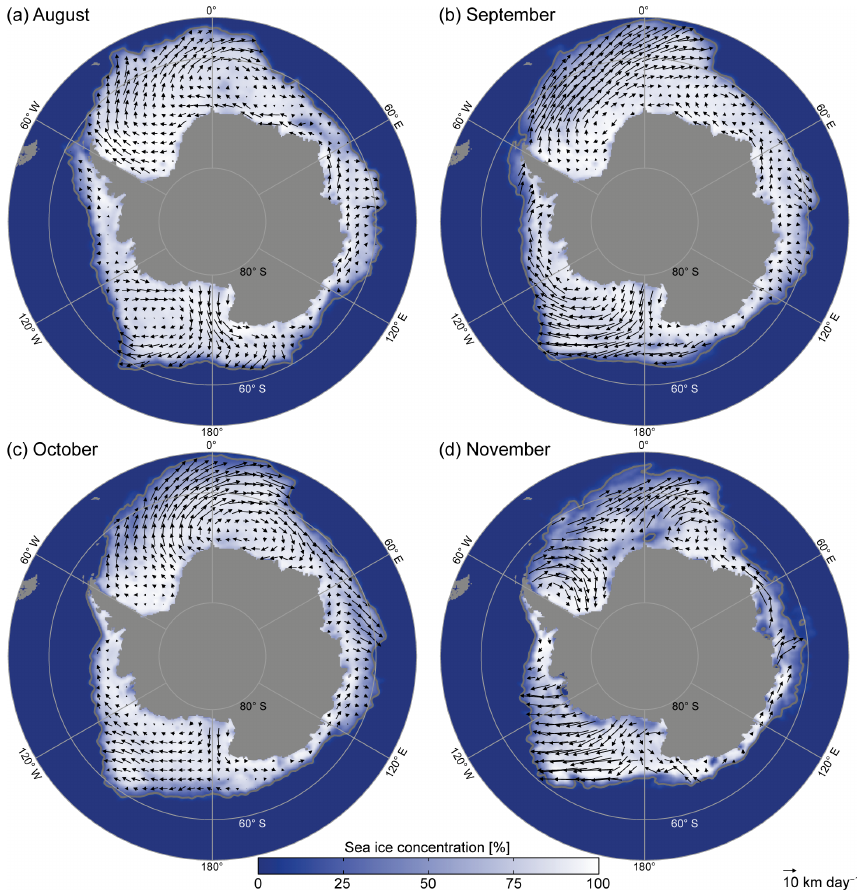
Figure 6. Monthly mean sea ice drift (arrows) for the months August to November 2016 (a–d) derived from the low-resolution sea ice drift product of OSI SAF (www.osi-saf.org; Lavergne, et al., 2010). White shading shows the respective monthly mean SIC derived from the NRT data (red; Maslanik and Stroeve, 1999, updated daily; provided by NSIDC). The gray contour line shows the 15% SIC